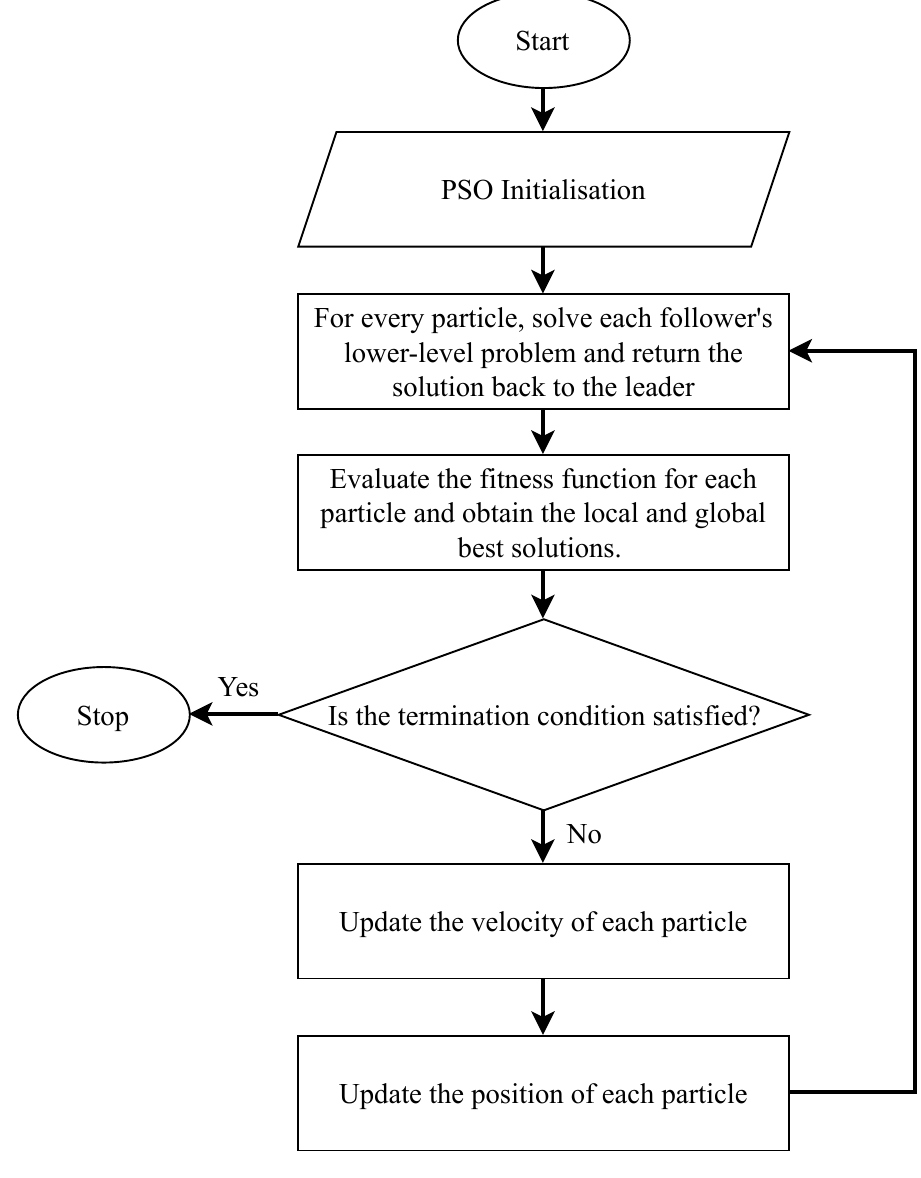
Figure 3. Flowchart of the PSO-based